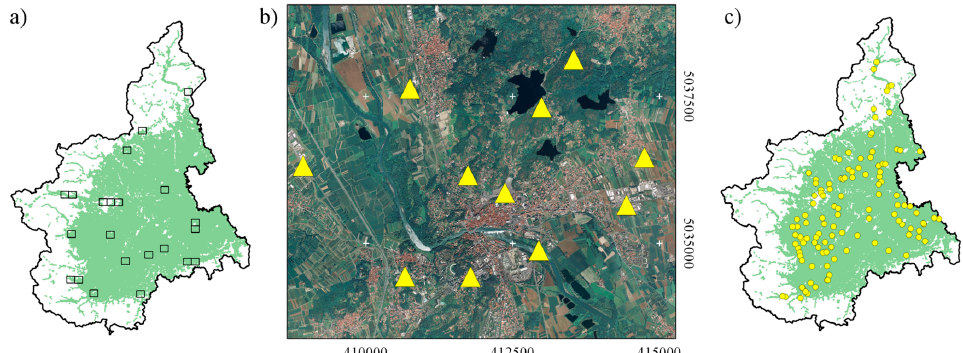
Figure 2. Spatial distribution of check points (CPAs and CPRs) used for geometric assessment. ( a ) spatial distribution of aerial orthoimages (rectangles) used for the absolute positioning assessment; ( b ) example of spatial distribution of CPAs (yellow triangles) withinone of the selected orthoimages; ( c ) spatial distribution of CPRs (yellow dots). Light green areas in ( a – c ) are the agriculture devoted one according to Corine Land Cover 2012 map.